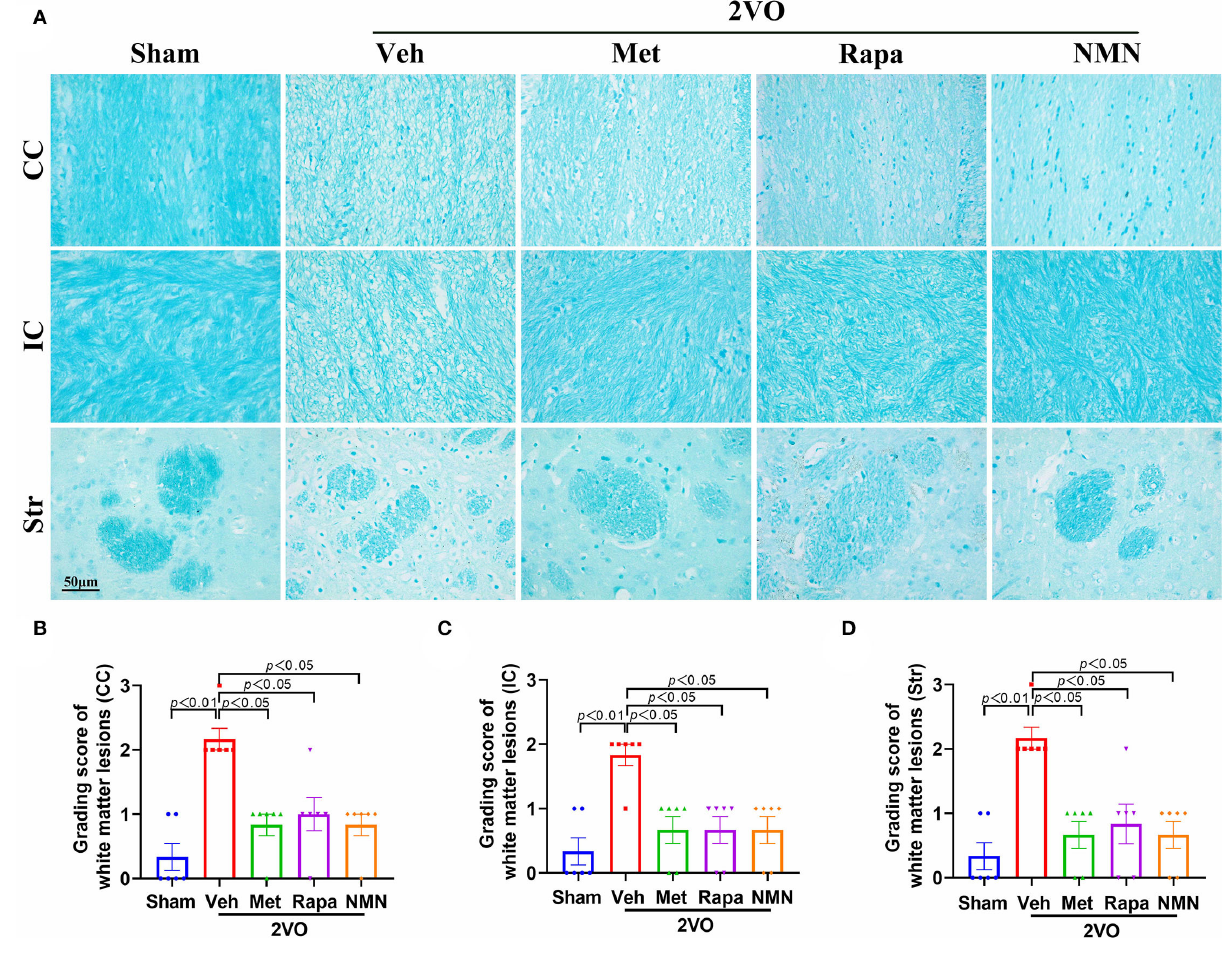
Frontiers in Neurology |